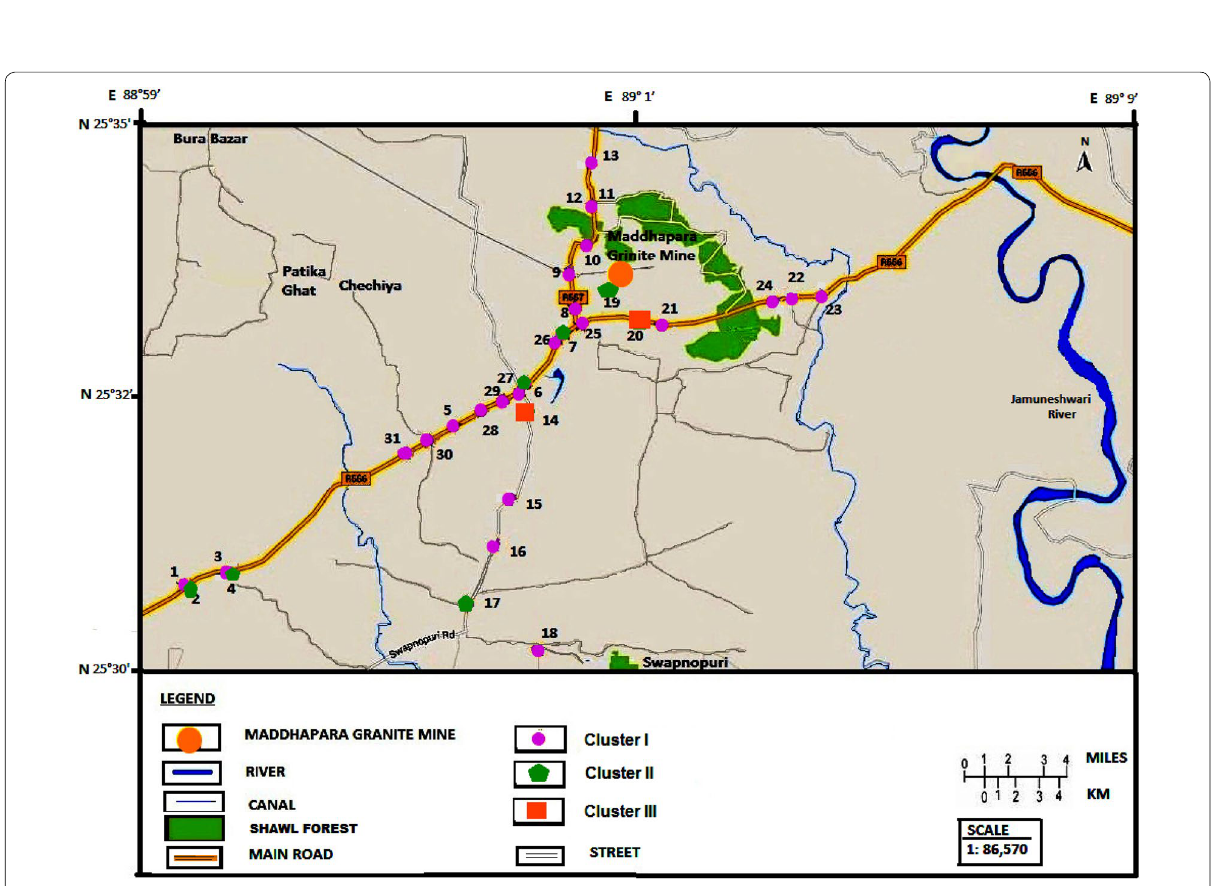
Fig. 11 The status of the quality of water around the mining area. The cluster group I reflects the best quality water of the